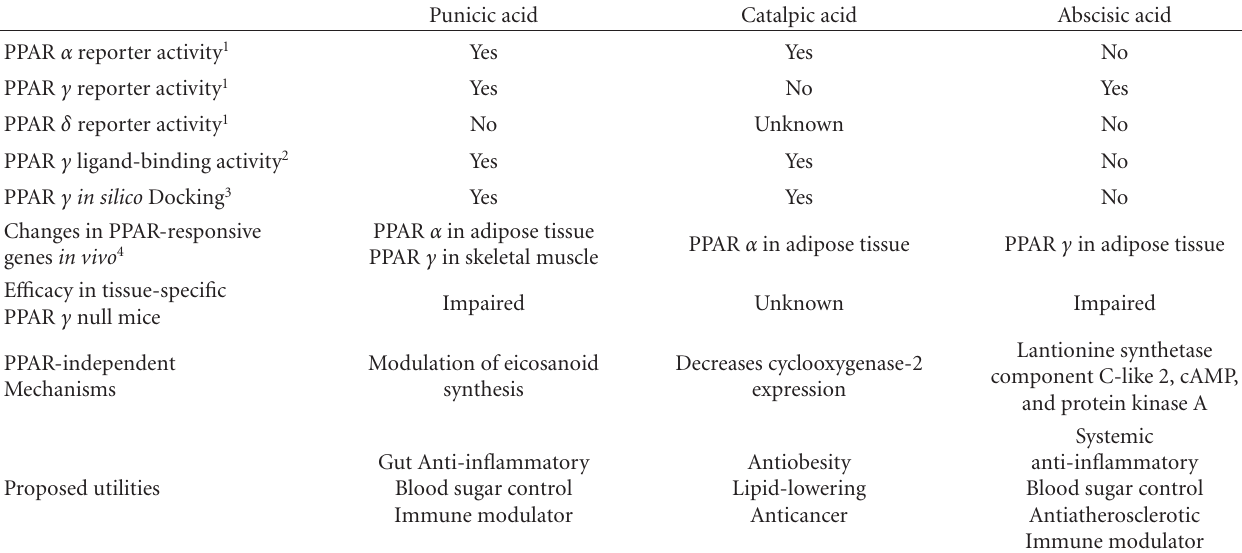
Table 1: Summary of activities of novel classes of peroxisome proliferator-activated receptor (PPAR)